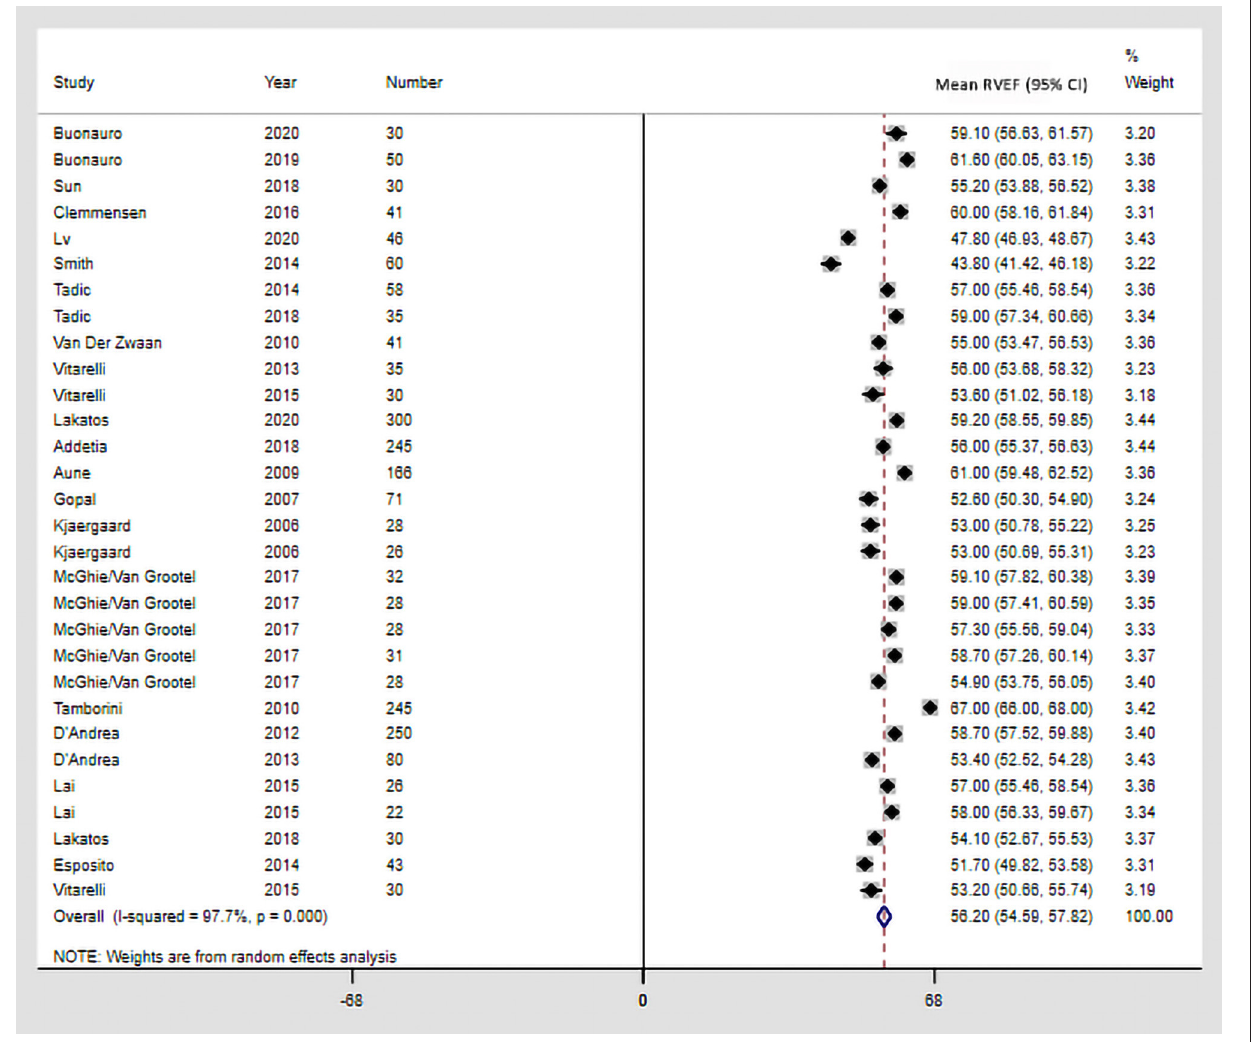
Frontiers in Cardiovascular Medicine |